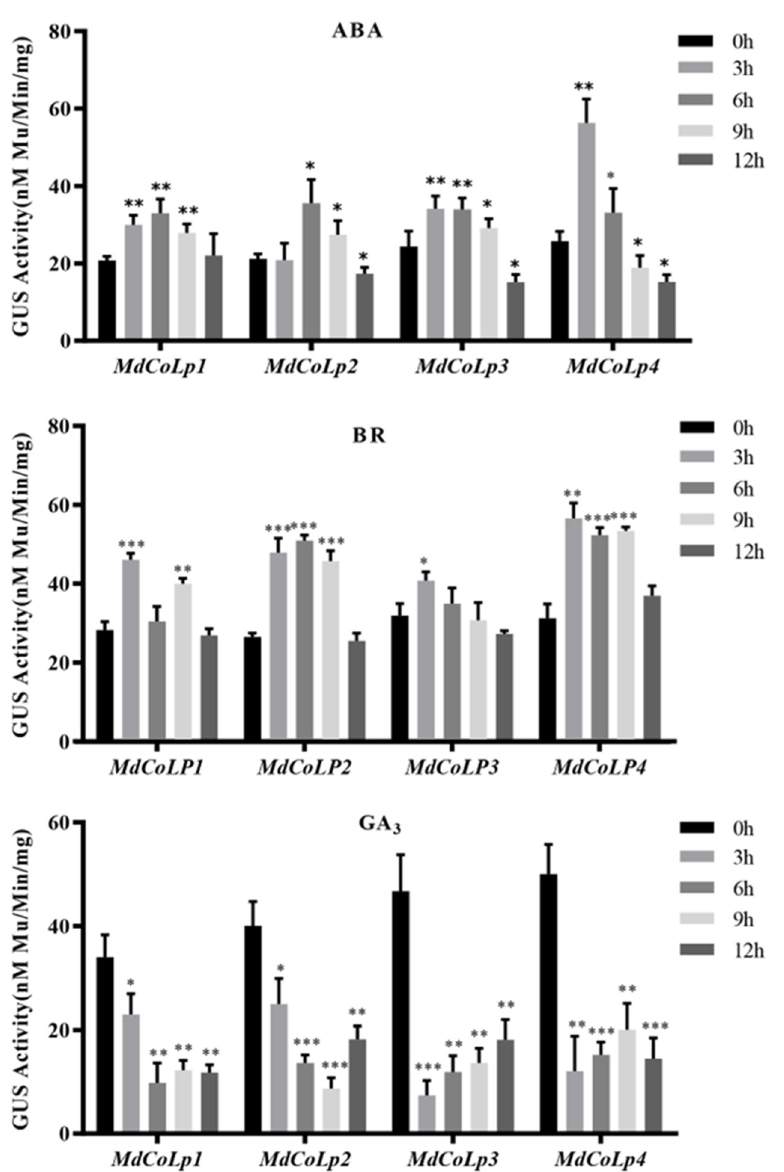
Figure 7. The effects of different hormones treatments on GUS activity under the control of different MdCoL promoter deletion segments in transgenic Arabidopsis lines. The GUS activity was detected in transgenic lines at 0, 3, 6, 9 and 12 h after treatment with 200 μM ABA, 200 μM BR and 500 μM GA 3 . Error bars indicate standard deviation from three independent biological replicates (* p < 0.05; ** p < 0.01; *** p < 0.001).